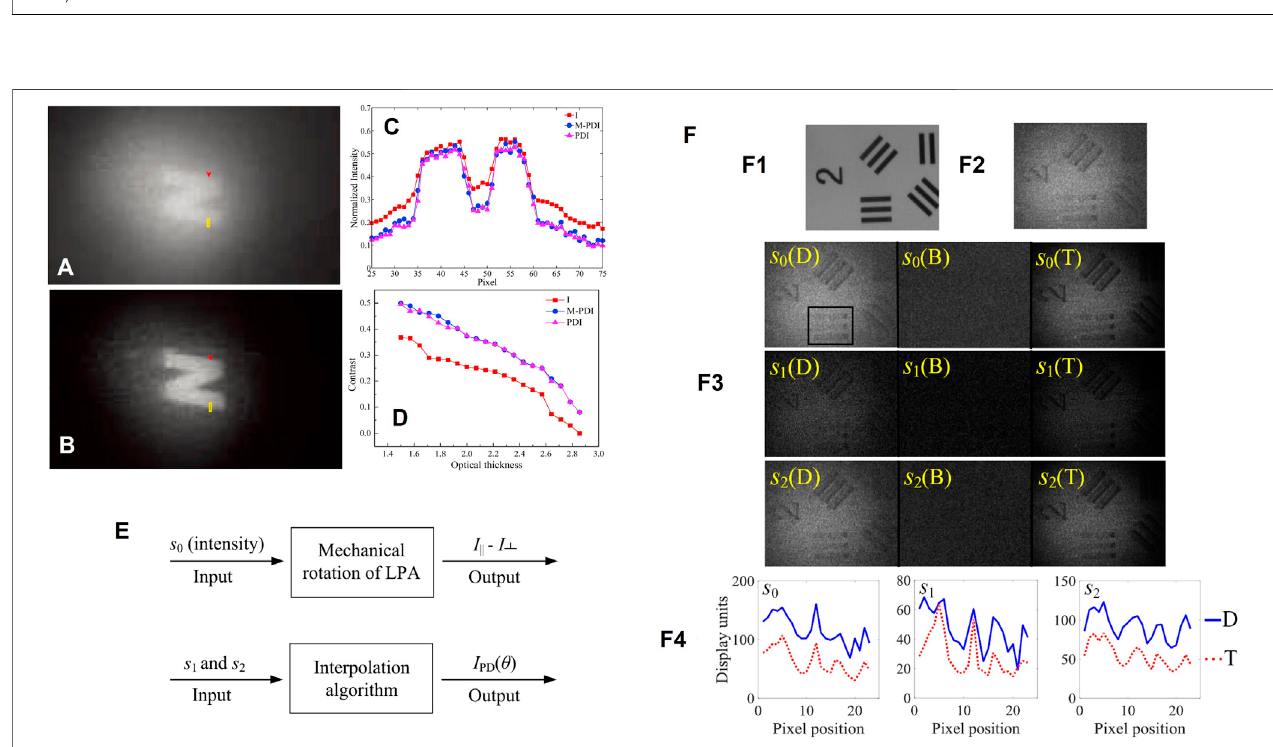
FIGURE 8 | (A) Raw intensity. (B) Imaging results by M-PDI. (C) Intensity pro fi les by raw intensity, traditional PI, and M-PDI. (D) Contrast distributions of the object obtainedbyrawintensity,traditional PI,and M-PDIversusopticalthickness(reprint fromElsevier:Optics andLaserTechnology[90],copyright2018). (E) Comparisonof traditional and interpolation method-based PDI systems. (F) Images corresponding to target in (F1) clear water and (F2) turbid conditions. (F3) Stokes vector elements for the direct measurement (D) , separated scatter (B) , and target (T). (F4) Generation of numerical plots for the direct measurement and separated target (reprint from IOP: Journal of Physics D: Applied Physics [91], copyright